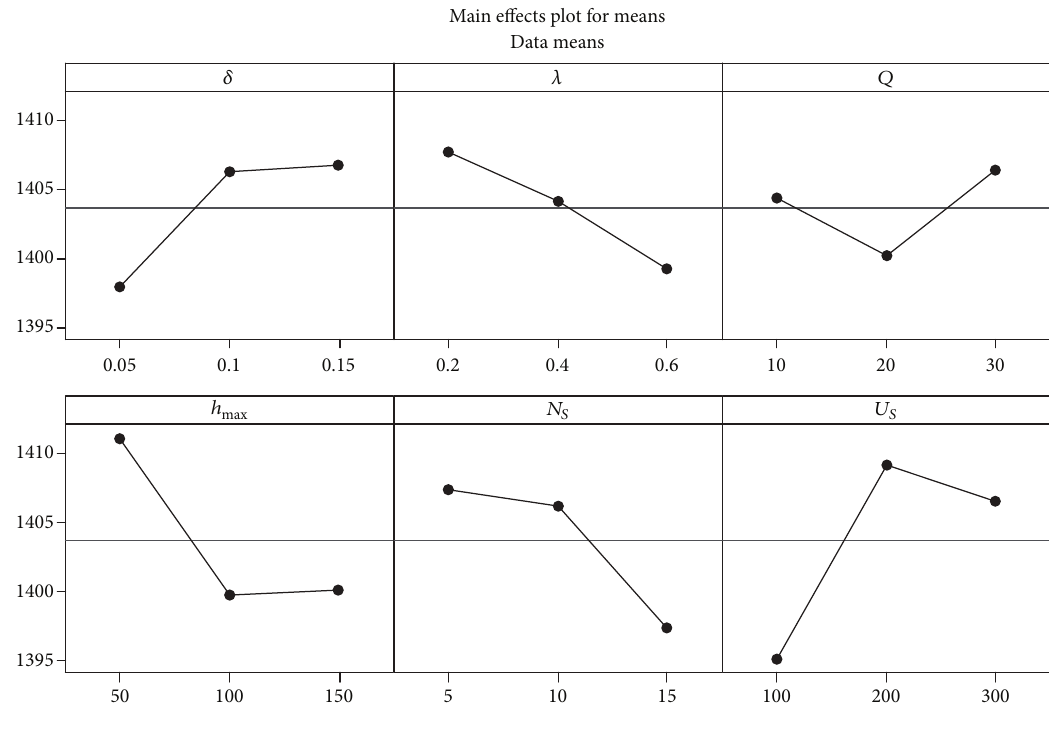
Figure 3: The impact of Stage 3